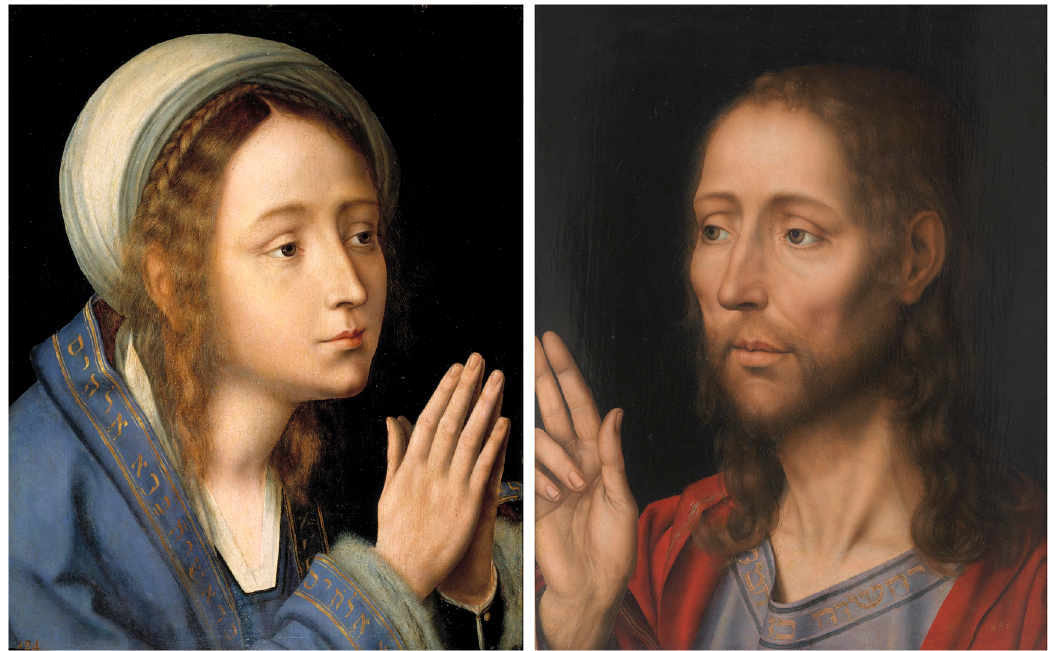
Figure 1. Jan Massys. Virgin Mary , after 1529. Quentin Massys. Christ the Saviour , ca. 1529. Madrid, the Prado Museum. Courtesy of the Prado Museum.